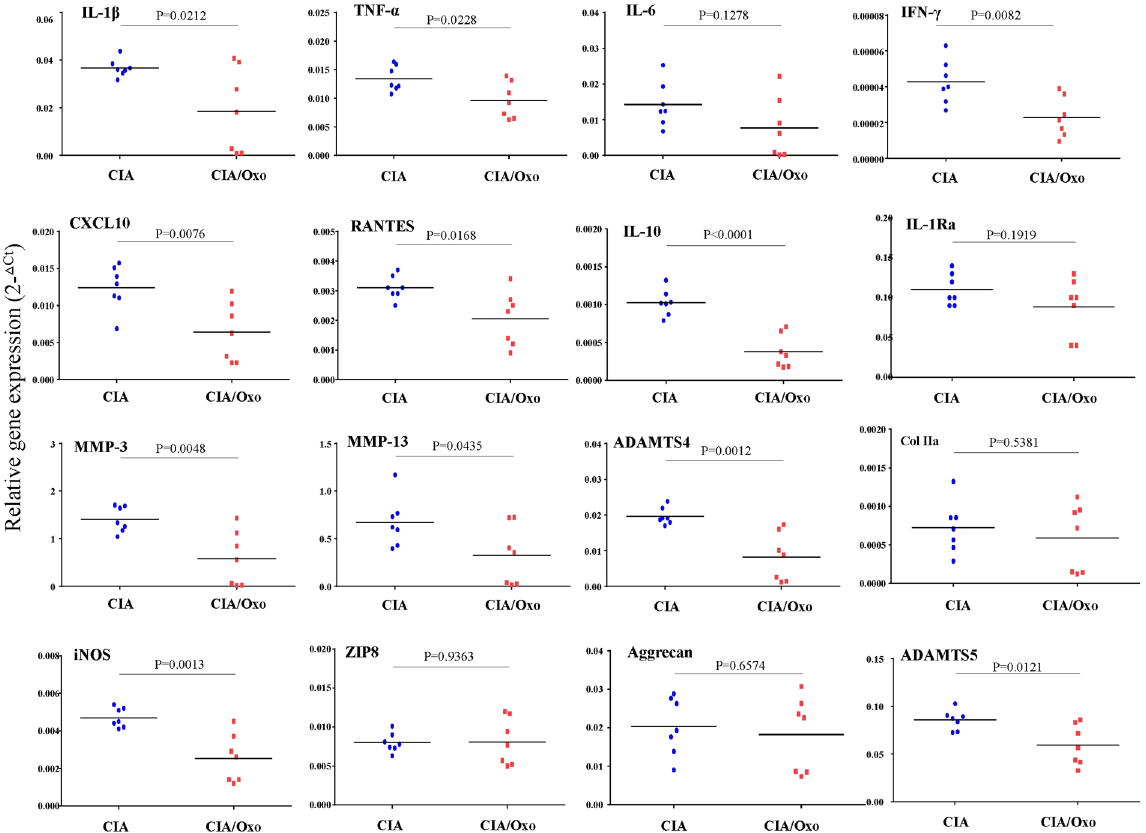
Figure 7. sUA regulated the mRNA expression of proinflammatory cytokines, chemokines, and several proinflammatory markers in the inflamed joints of CIA mice. The tissues taken from the entire joint/paw of water- and oxonic acid-treated CIA mice (7 for each) were collected, and the mRNA expression levels of several proinflammatory cytokines, chemokines, and inflammation-related molecules were analysed, as indicated previously. The primers for the individual genes whose expression levels were measured by qPCR are shown in Supplementary Table 1.